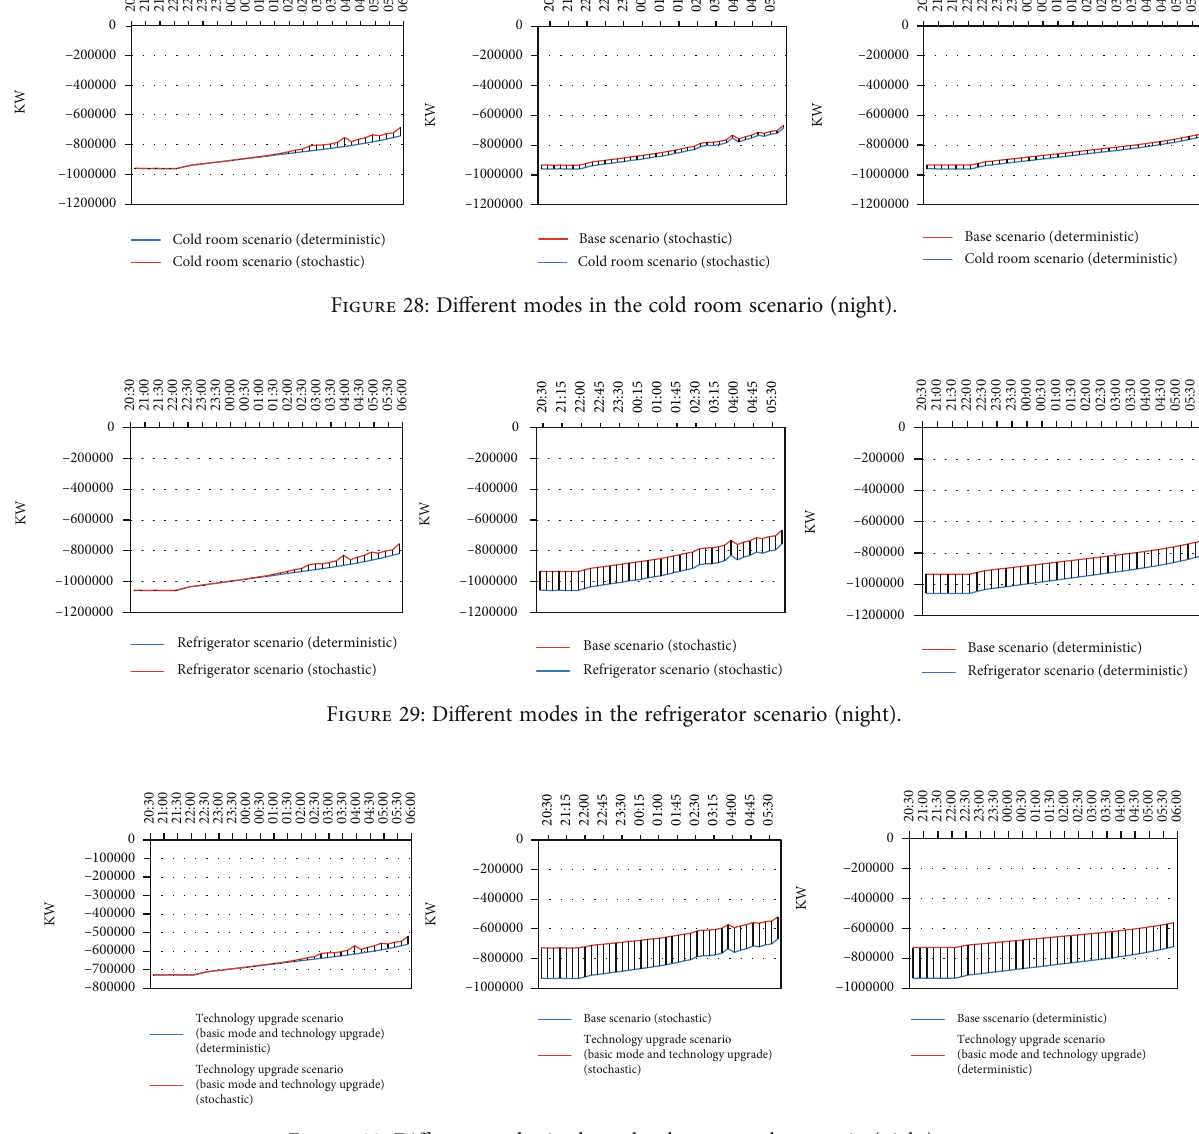
Figure 30: Di ff erent modes in the technology upgrade scenario